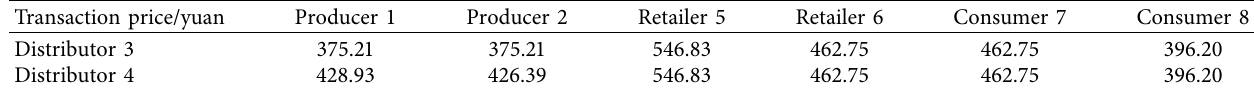
Table 5: Transaction prices of green products in the GSCDN after the adjustment of cost functions.